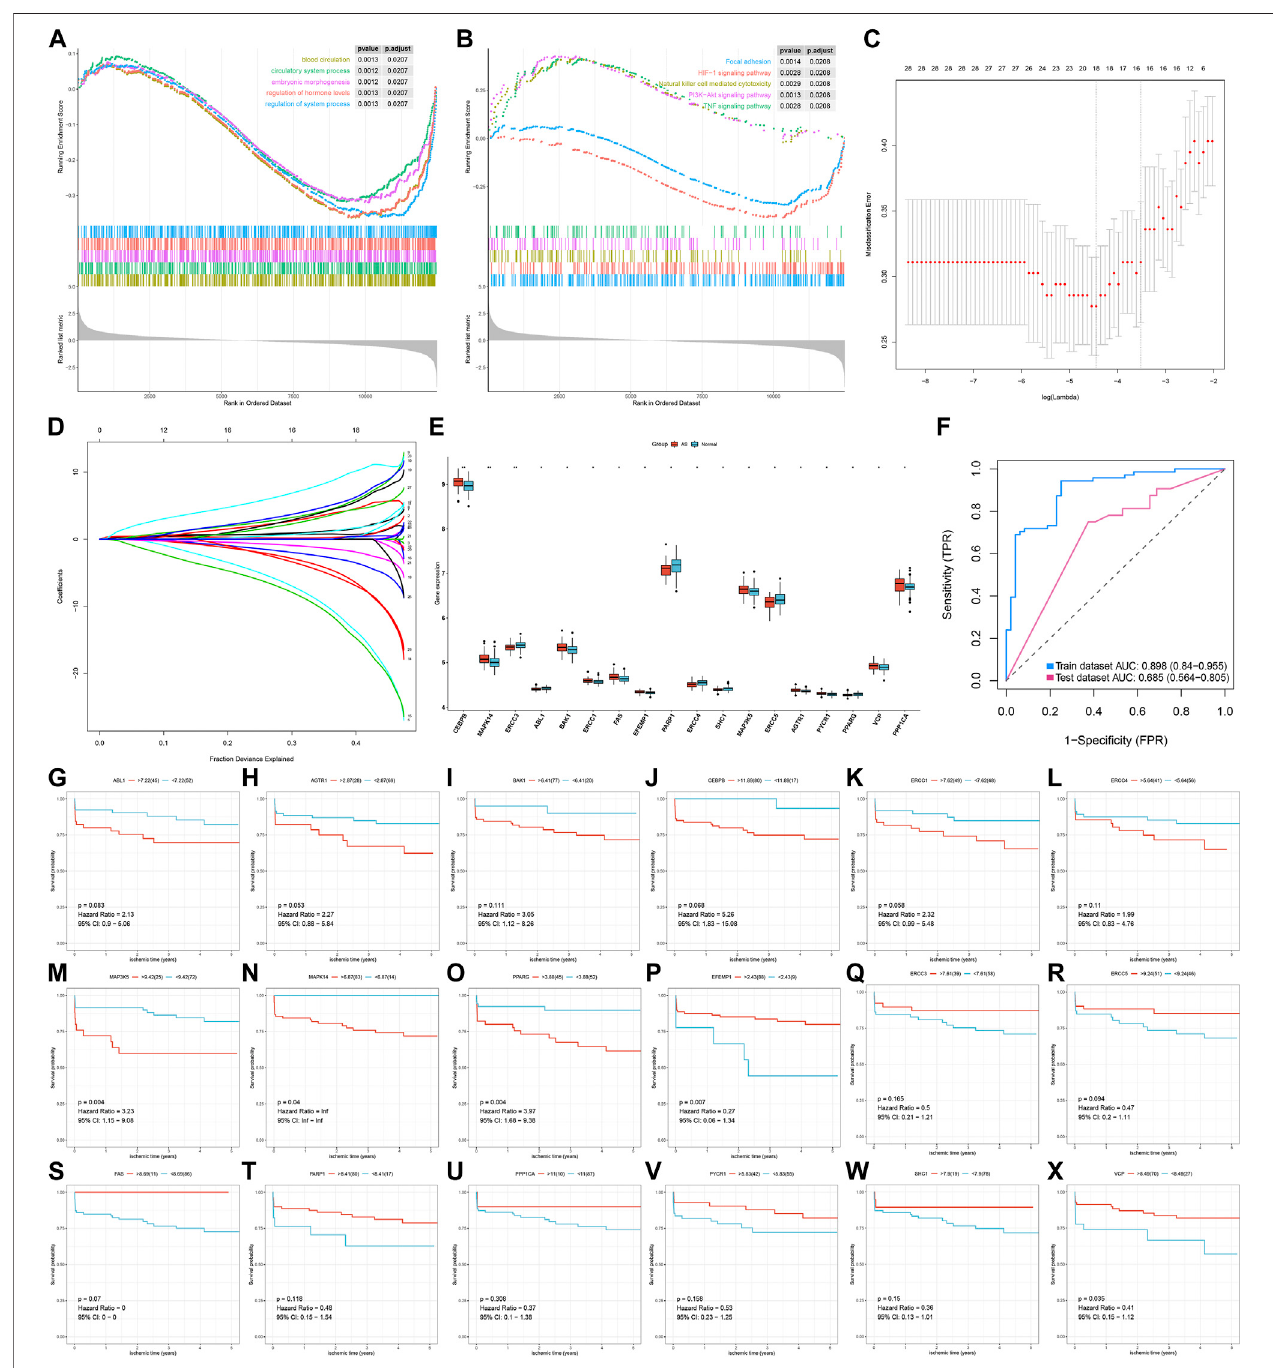
FIGURE 2 | Development of an aging-related gene signature for AS diagnosis. (A) GSEA results for the activation of biological processes in AS than non-AS samples. (B) GSEA results for the activation of KEGG pathways in AS than non-AS samples. (C) Tuning feature selection in the LASSO model. (D) LASSO regression coef fi cient pro fi les. (E) Boxplotsfortheexpression ofkeyAS-speci fi caging-related genesintheLASSOmodel betweenASand non-ASsamples.* p < 0.05; ** p < 0.01. (F) ROC curves for evaluating the diagnostic ef fi cacy of the LASSO model in GSE20129 (training set) and GSE43292 (testing set). (G – X) Survival analysis of AS patients with high and low expressions of key AS-speci fi c aging-related genes in the GSE21545 dataset.